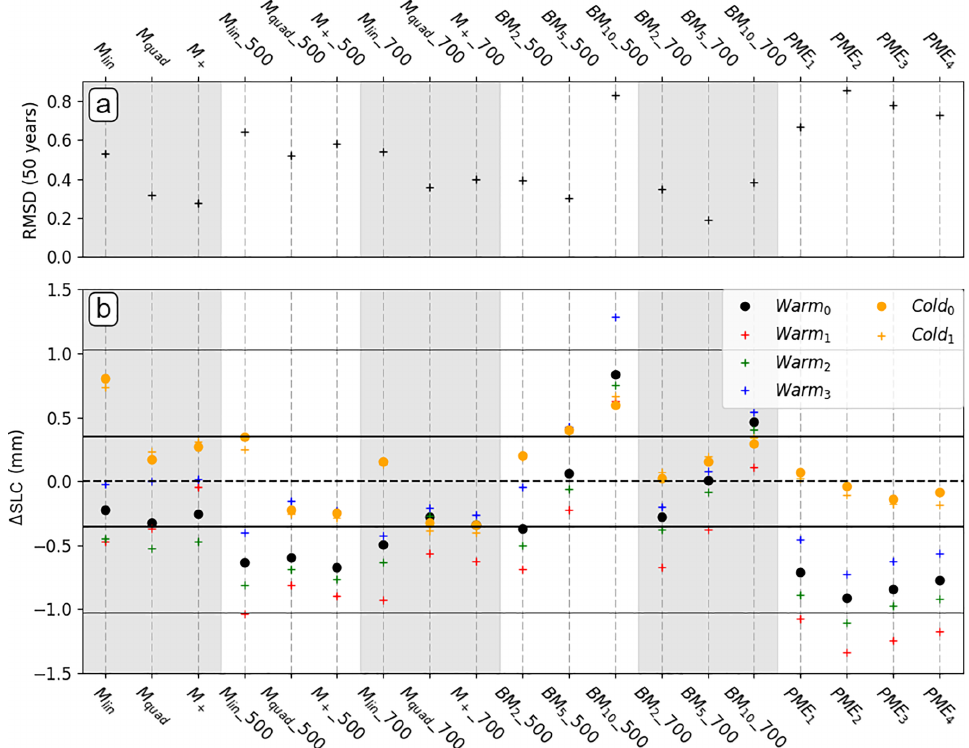
Figure 9. Performance of parameterisations compared to coupled simulations, calculated at the 50th year of simulations. (a) Root mean square deviation (RMSD) in SLC of every parameterised simulation with respect to the average of coupled simulations. (b) Difference between SLCs from parameterisations and coupled simulations for all the experiments. The grey shading is only to ease the comparisons between the